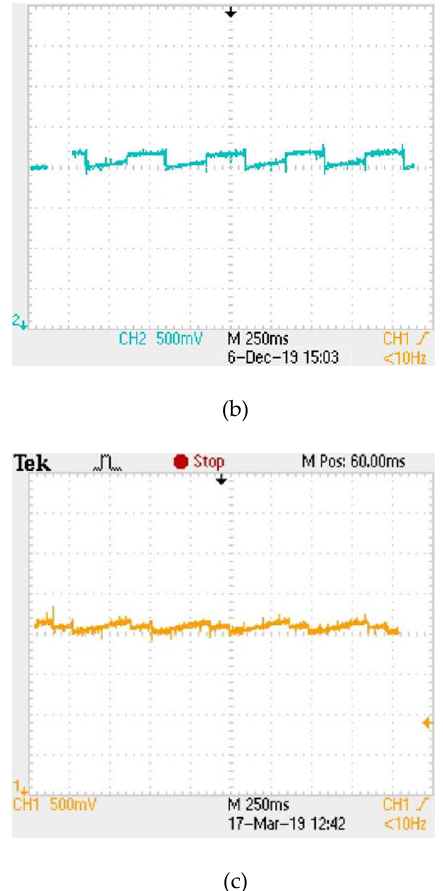
Figure 17. Output voltage ripple of three converters. ( a ) Boost converter. ( b ) Double-boost converter. ( c ) Four-phase interleaved DC / DC converter.